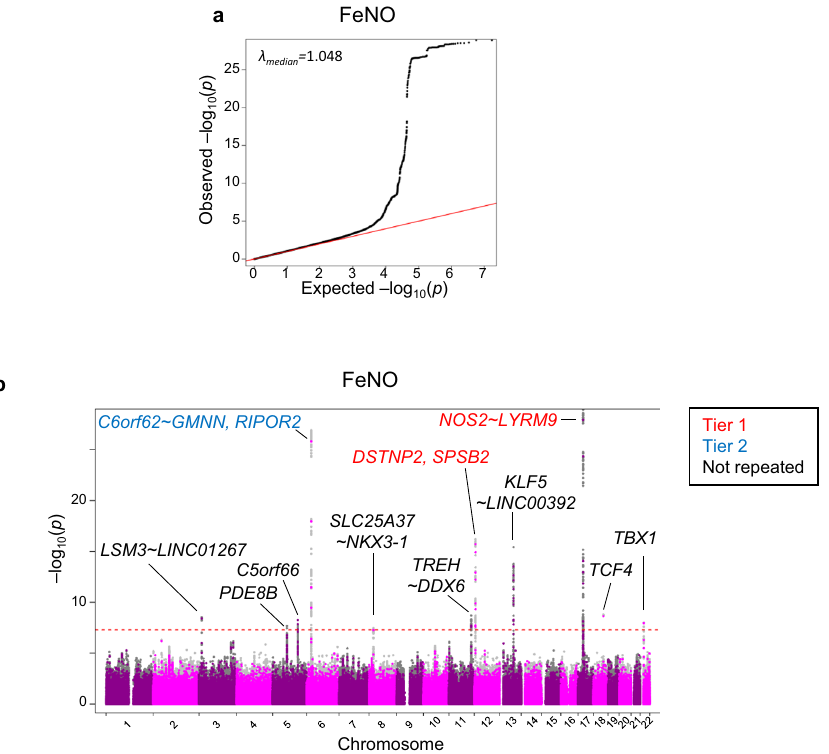
Fig. 6 GWAS for association with the levels of FeNO at the Discovery Stage. a A Quantile-quantile (QQ) plot of the observed versus the expected log10( P ) values in FeNO is shown with the in fl ation factor ( λ ). b The Manhattan plot of GWAS for the association with FeNO shows the chromosomal position of variants exceeding the genome-wide signi fi cance threshold ( P < 5 × 10 – 8 as indicated by the dotted red line). Gene names in red correspond to tier 1 loci ( P < 5 × 10 − 8 both in the Discovery Stage and Validation Stage); gene names in blue correspond to tier 2 loci ( P < 5 × 10 − 8 in the Discovery Stage and P < 5 × 10 − 5 in the Validation Stage with consistent directions of effect); gene names in black correspond to genetic loci which had P < 5 × 10 − 8 in Discovery Stage but not repeated by Validation Stage. Coloured circles mean the variants directly analysed. Grey circles mean the variants detected by genotype imputation. GWAS genome-wide association study, FeNO exhaled nitric